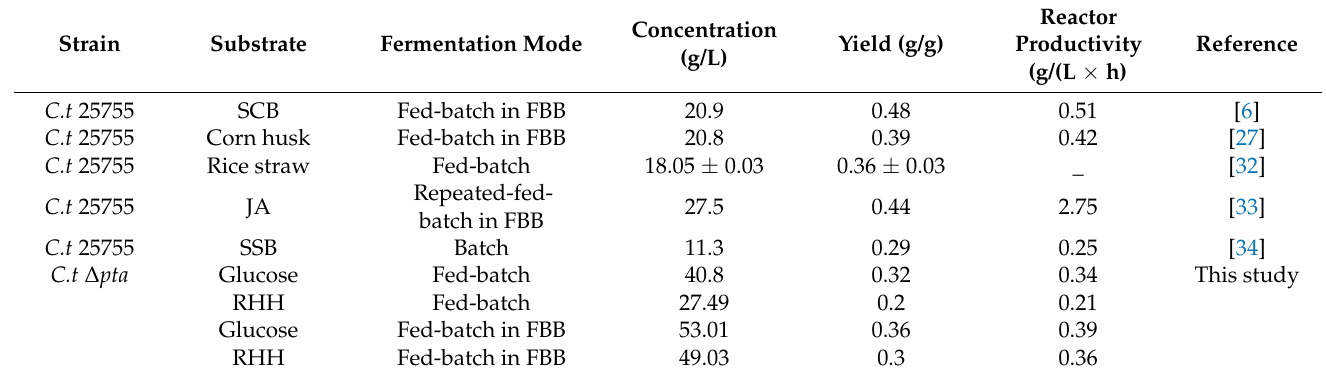
Table 6. Comparison of butyric acid production by C.tyrobutyricum using different